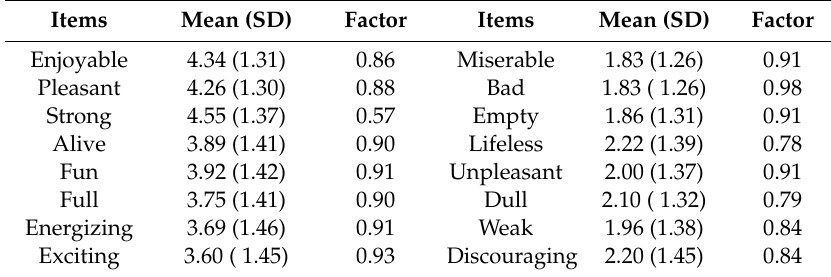
Table 2. Descriptive Statistics and Exploratory Factor Loadings for the married